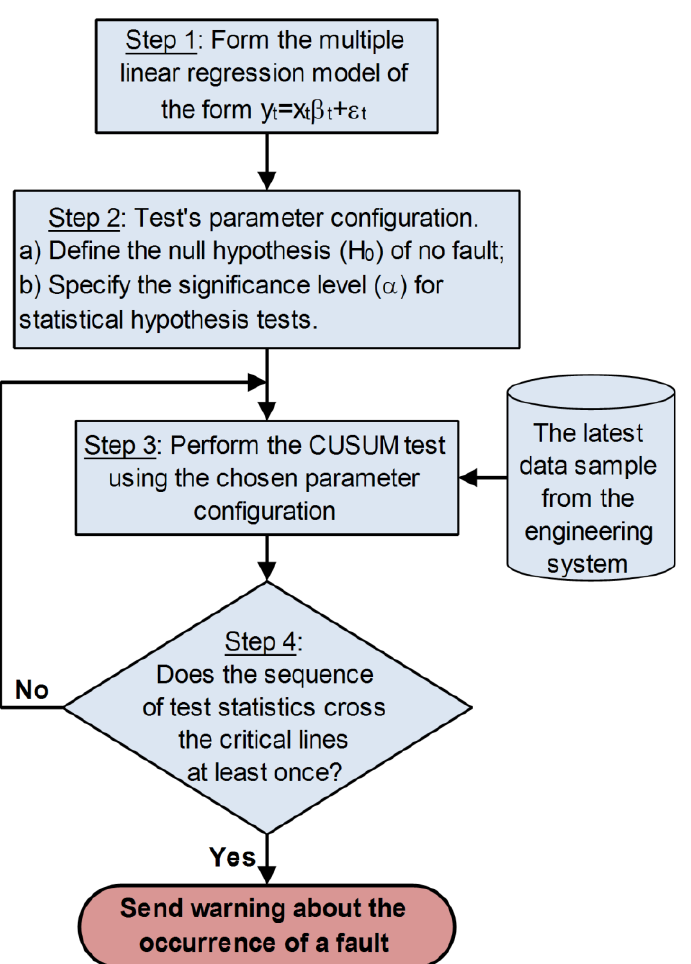
Figure 3. CUSUM-based computation procedure for condition monitoring and fault detection of engineering systems and/or structures.